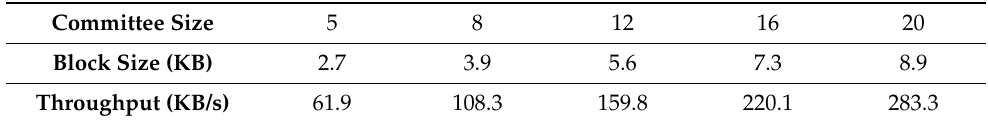
Table 3. Data throughputs vs. committee